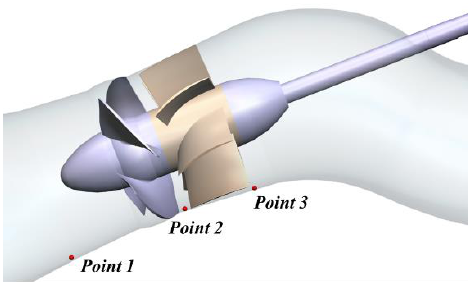
Figure 11. Distribution of the three monitoring points.